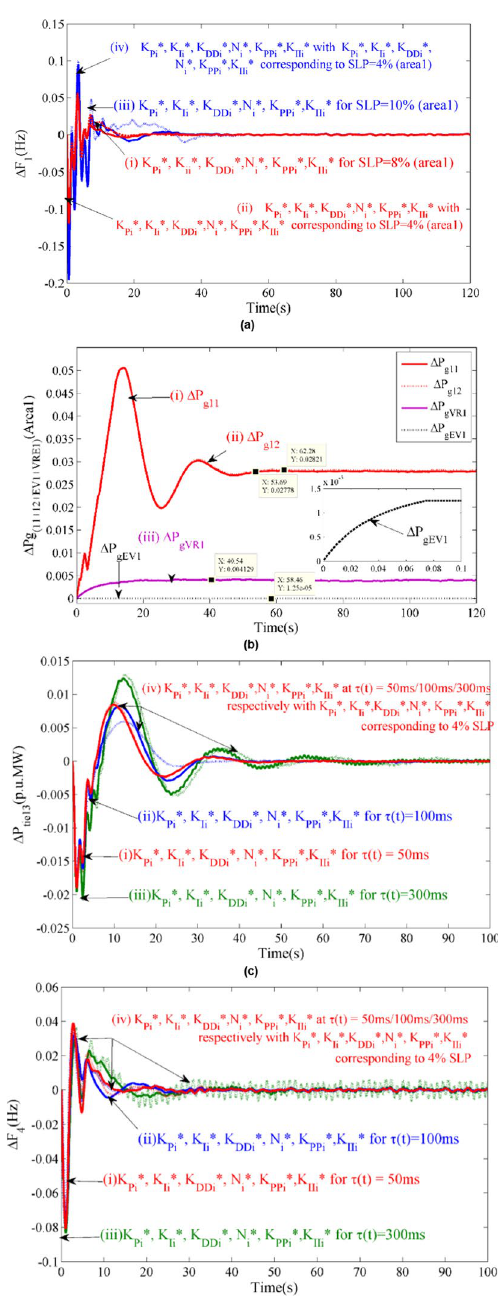
Fig. 6 Comparison of system dynamic responses during higher violation of contracted demand and different time delays in the system. a Frequency deviation in area 1 for 4% and 6% violations in contracted demand from nominal one. b Power generation